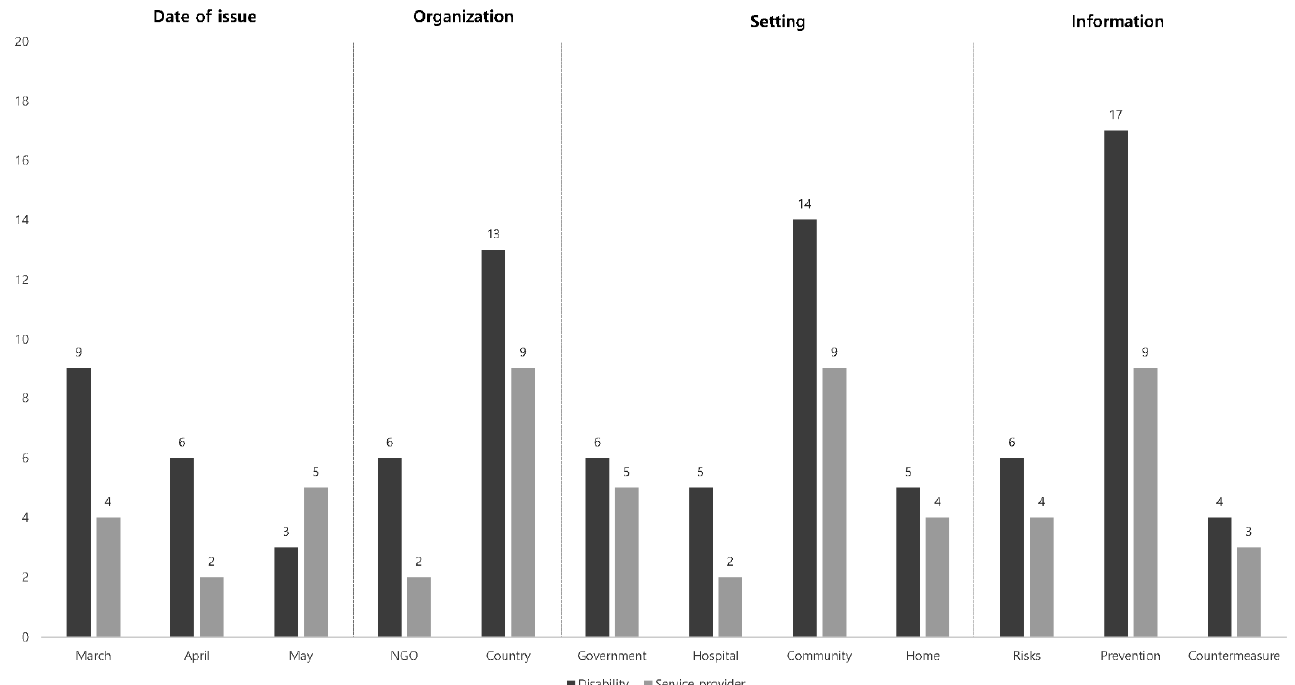
Figure 4. Guidelines applicable to disability and service provider entities.